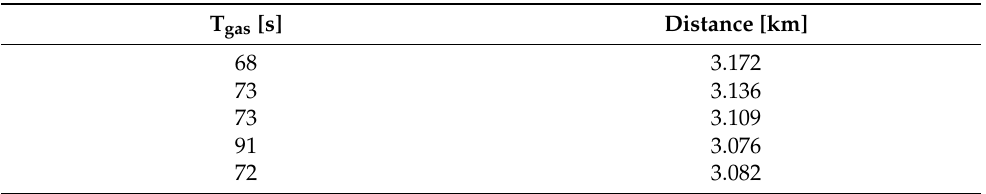
Table 6. Working time on gasoline T gas (s) and the distance traveled in the Low phase of the world harmonized light-duty test cycle (WLTC) cycle (km).